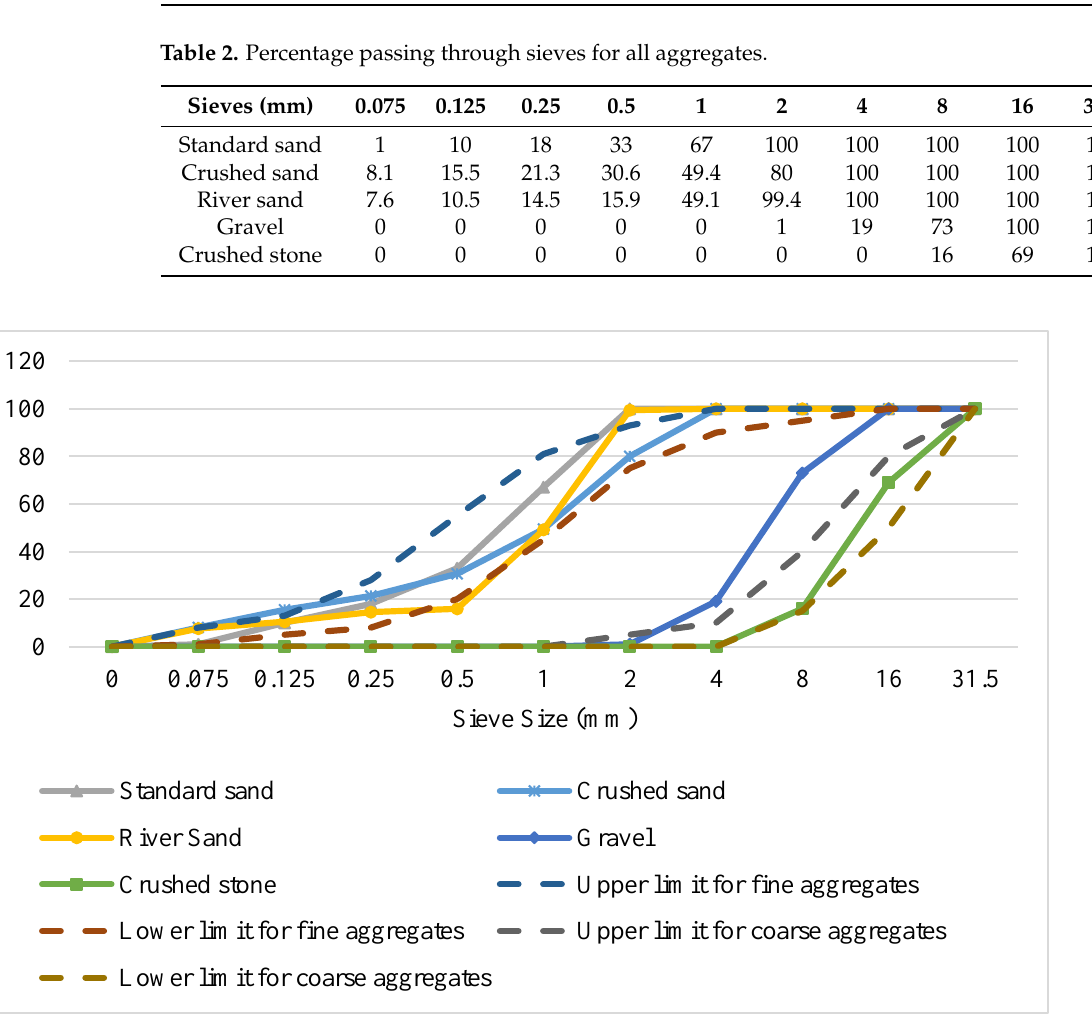
Figure 2. Grain size distribution (granulometric curve) of all